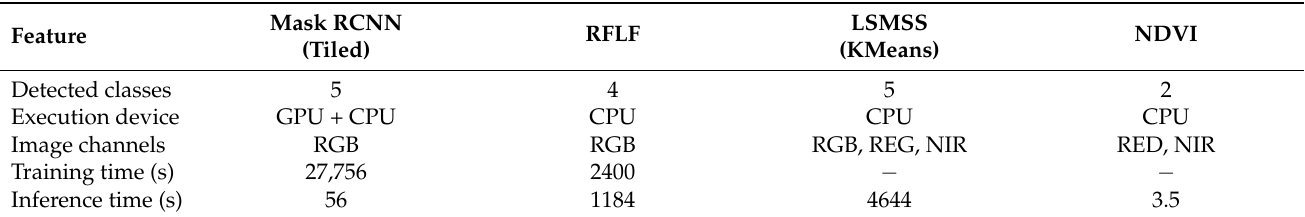
Table 4. Comparison of segmentation capabilities performed by Mask RCNN, RFLF, LSMSS, and NDVI, executed on the same orthomosaic.